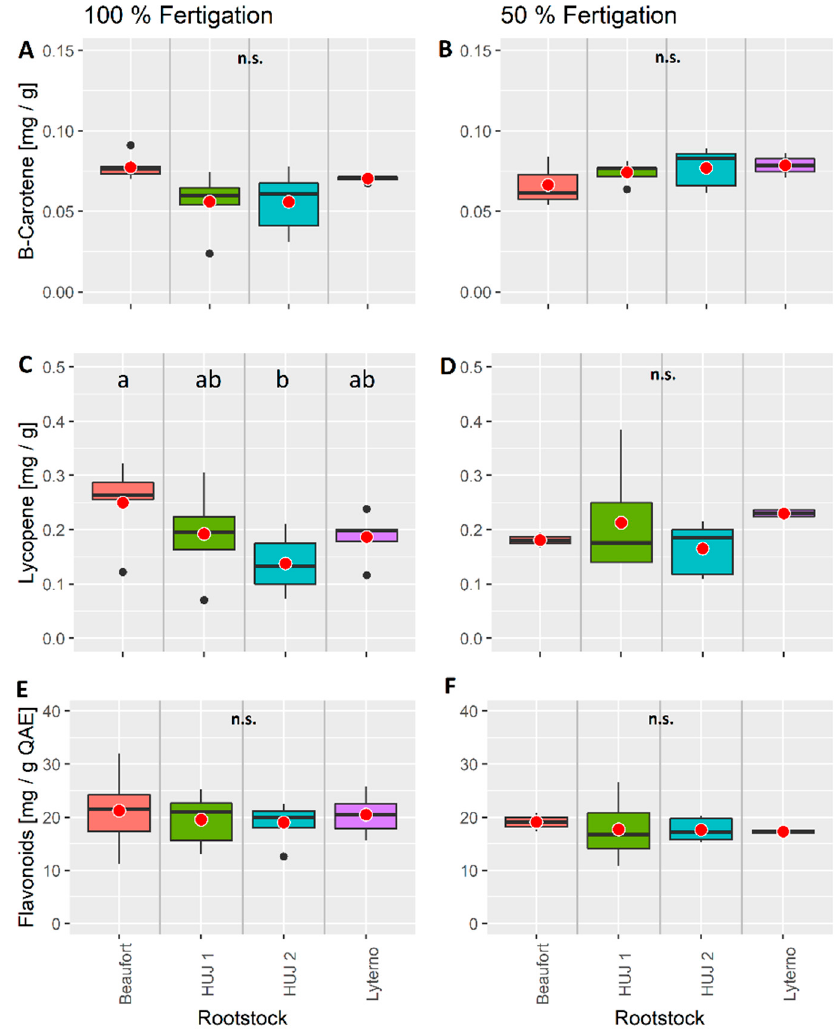
Figure 4. Quality parameters of ‘Lyterno’ fruits grafted onto four different rootstocks and supplied with optimal ( A , C , E ) and reduced ( B , D , F ) fertigation: β -carotene content (mg/g DM), ( A , B ); lycopene content (mg/g DM), ( C , D ); flavonoid content (mg/g DM quercetin equivalents) ( E , F ); n = (2–6). n.s.: not significant, p-value 0.05.